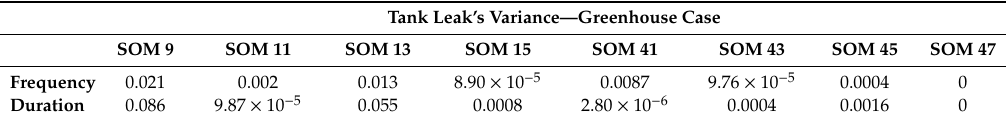
Table 4. Variance per SOM in the greenhouse’s